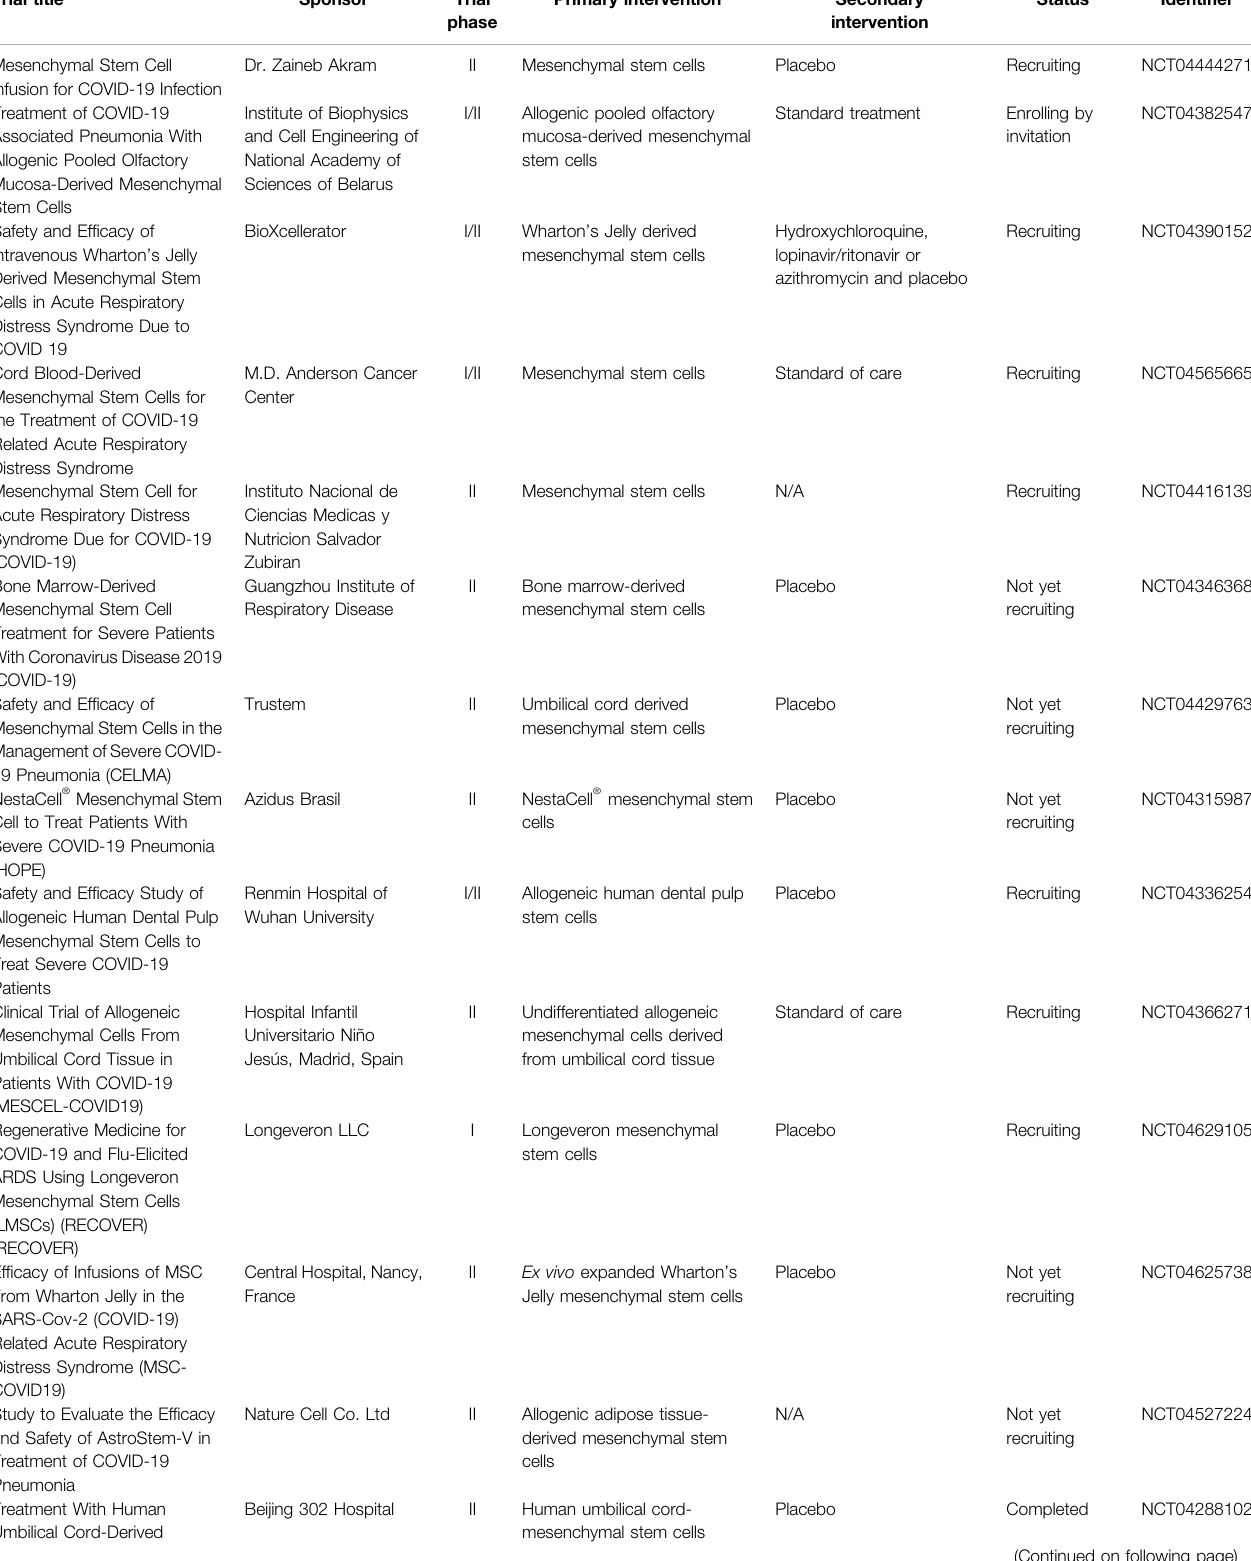
TABLE 8 | Summary of clinical trials of mesenchymal stem cells (MSCs) on COVID-19